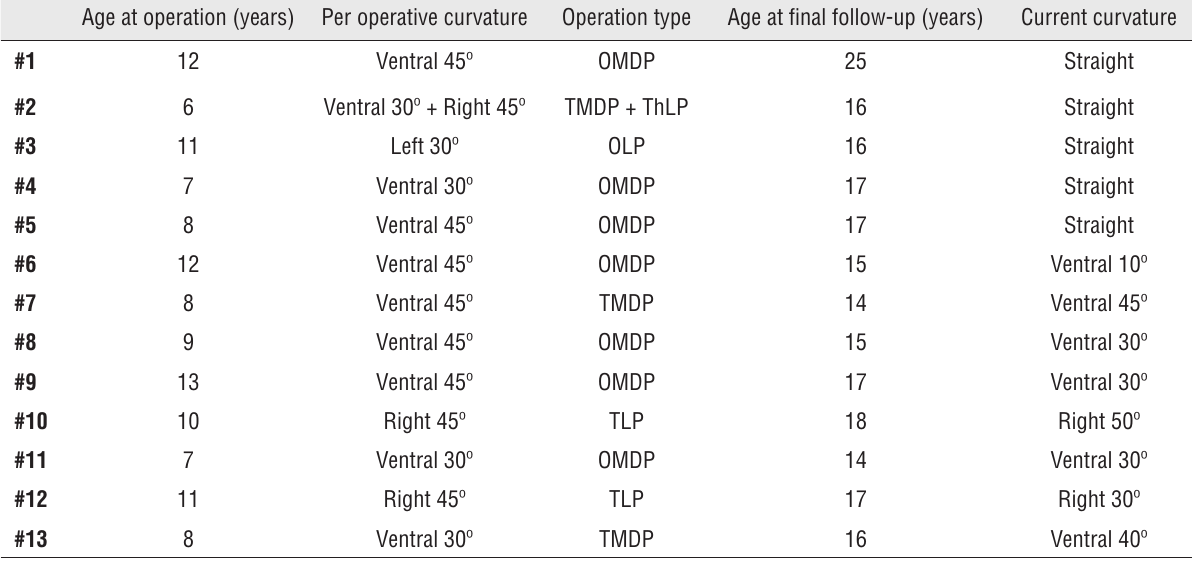
Table 1 - Summary of the patients. Age at operation